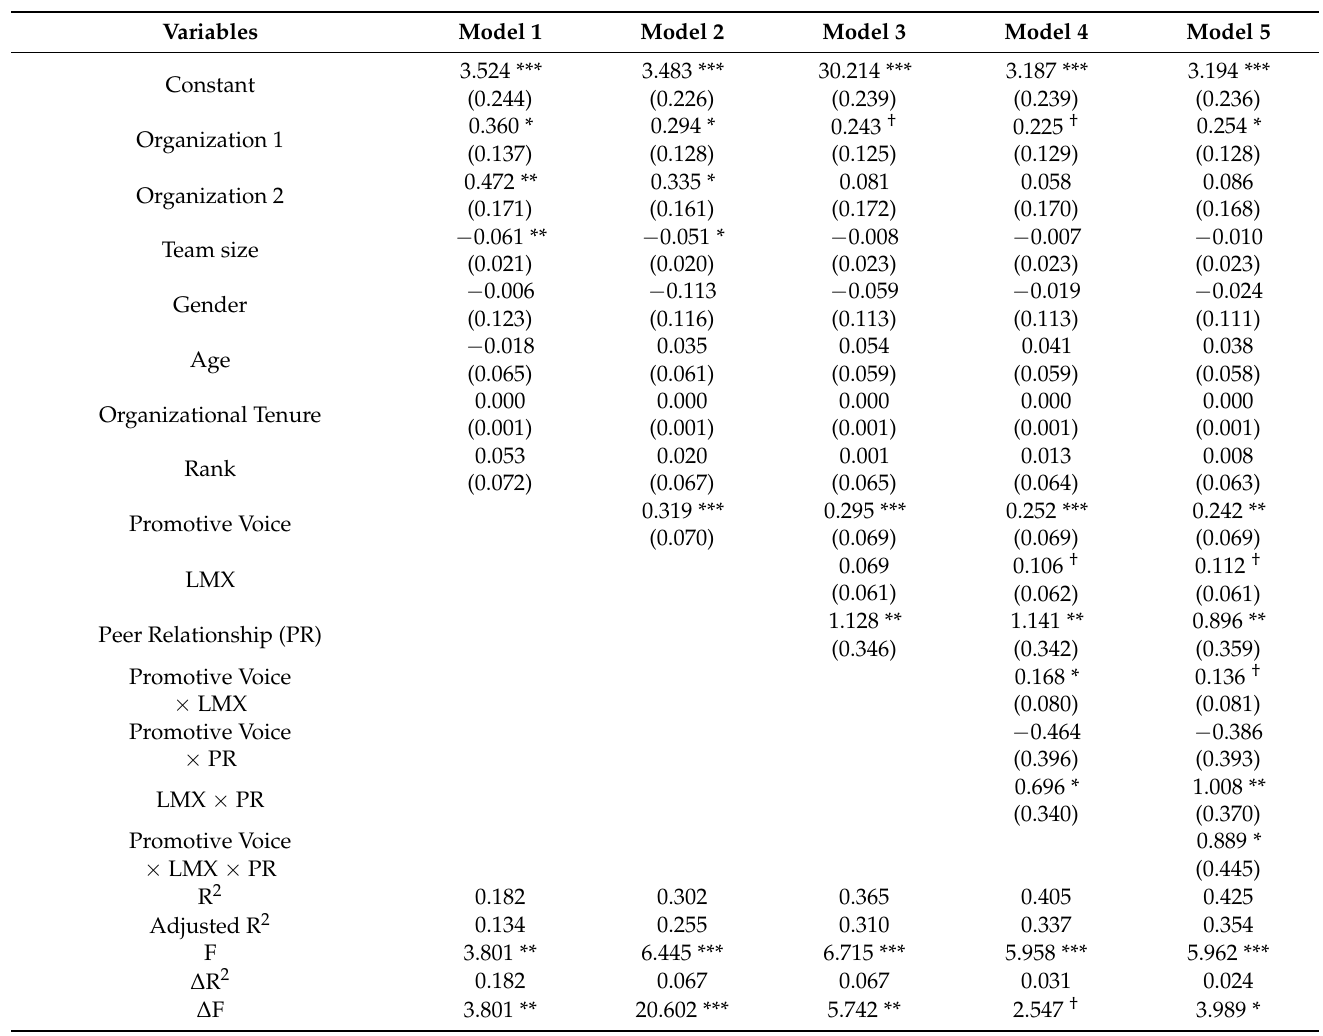
Table 4. Results of Regression Analyses for Promotive Voice and Individual Influence.